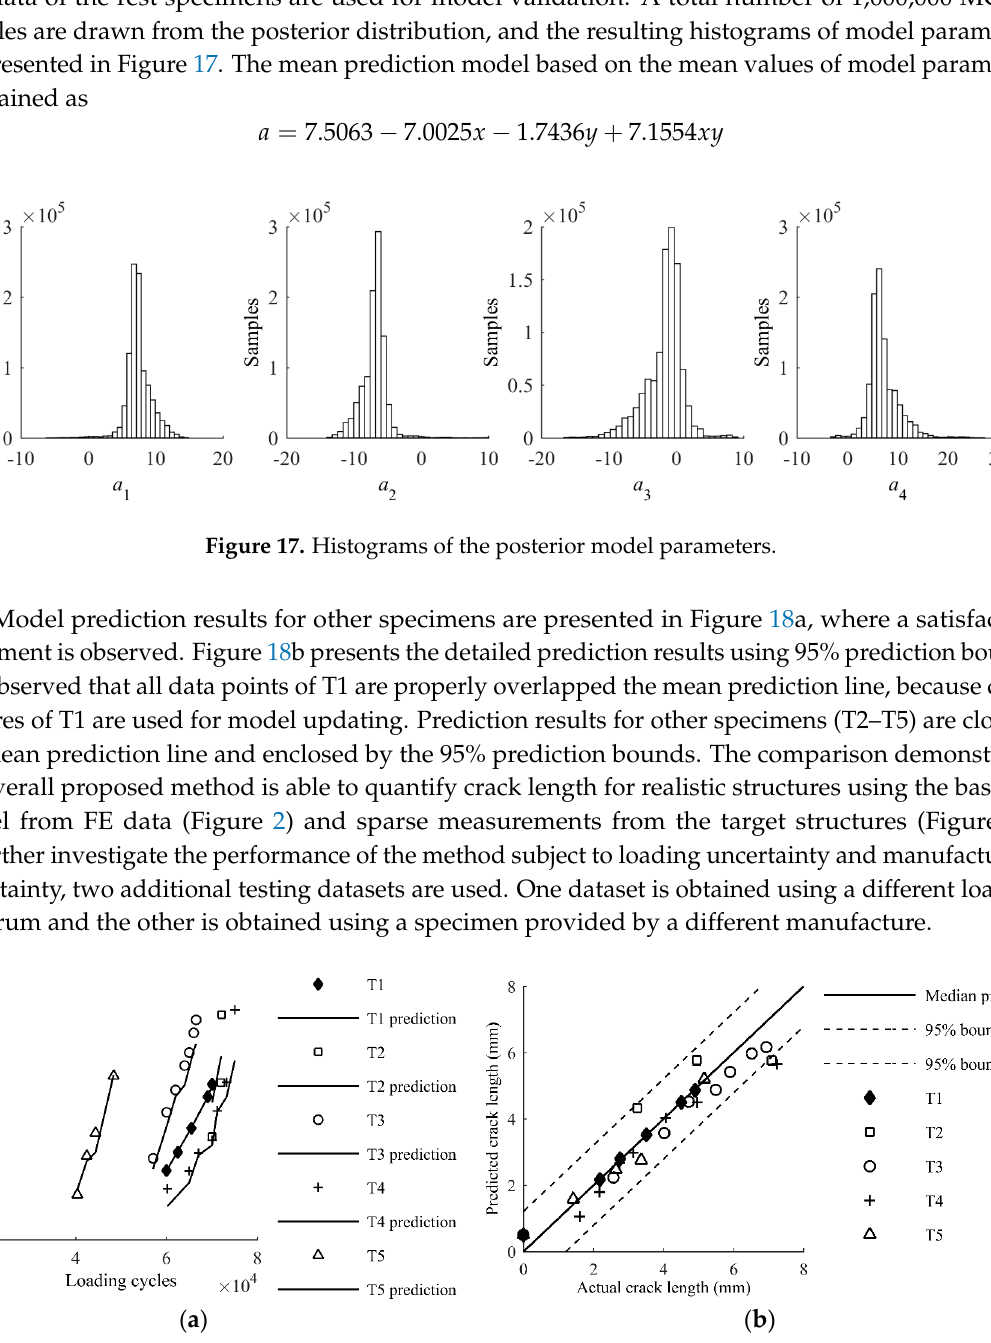
Figure 18. Model predictions and actual measurements of T1–T5: ( a ) crack growth; and ( b ) crack lengths.